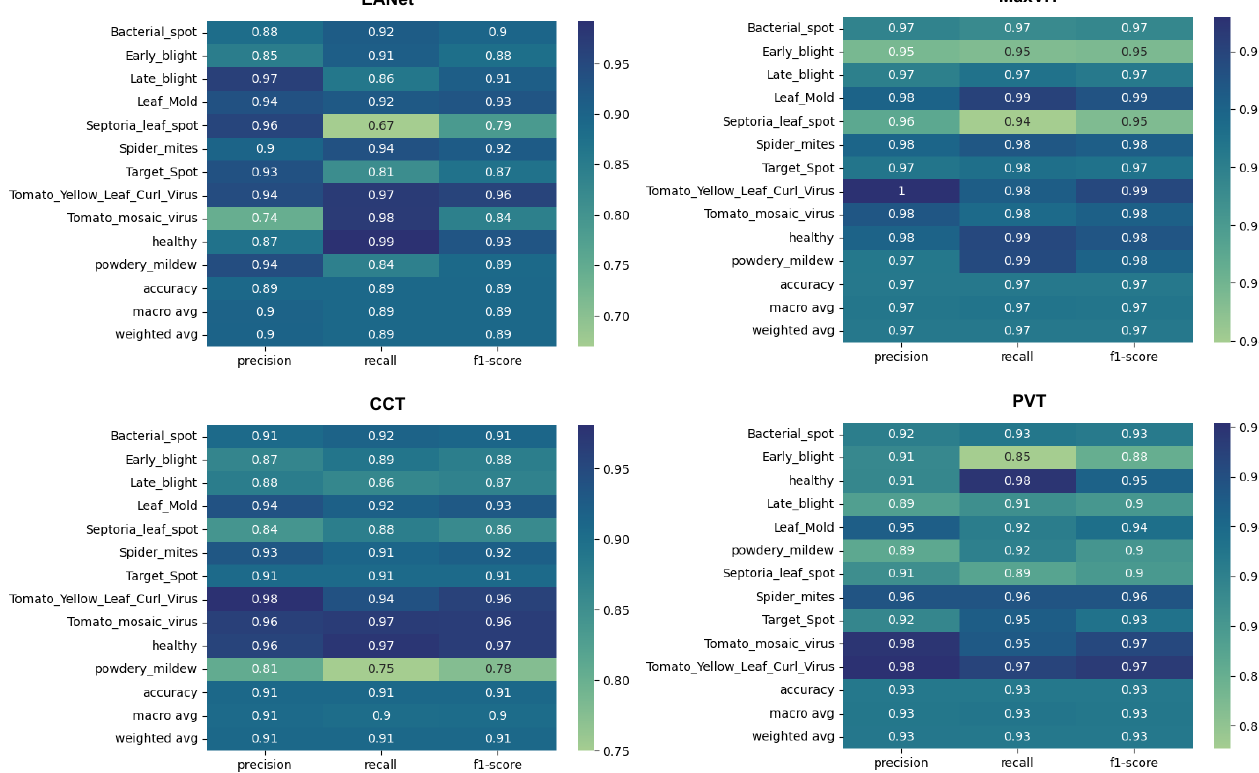
Figure 10. Classification